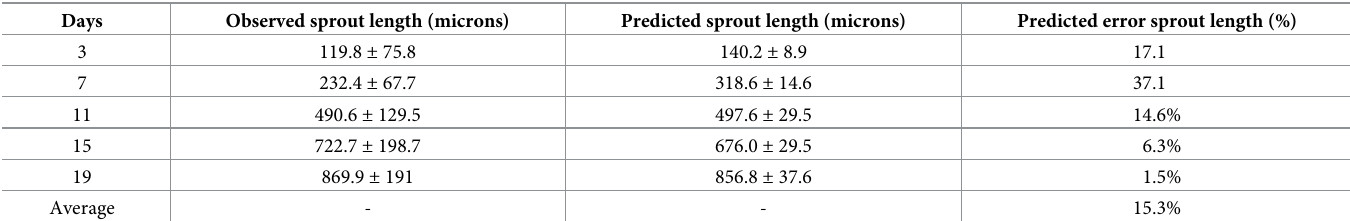
Table 3. Error in calibration and prediction of sprout length using the